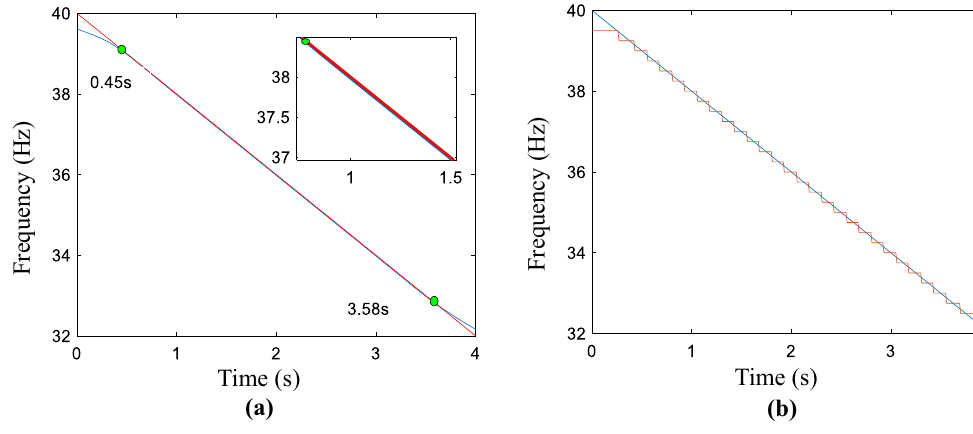
Figure 1. Simulated signal. ( a ) Obtained result by using the proposed method, ( b ) the estimated and real curves.